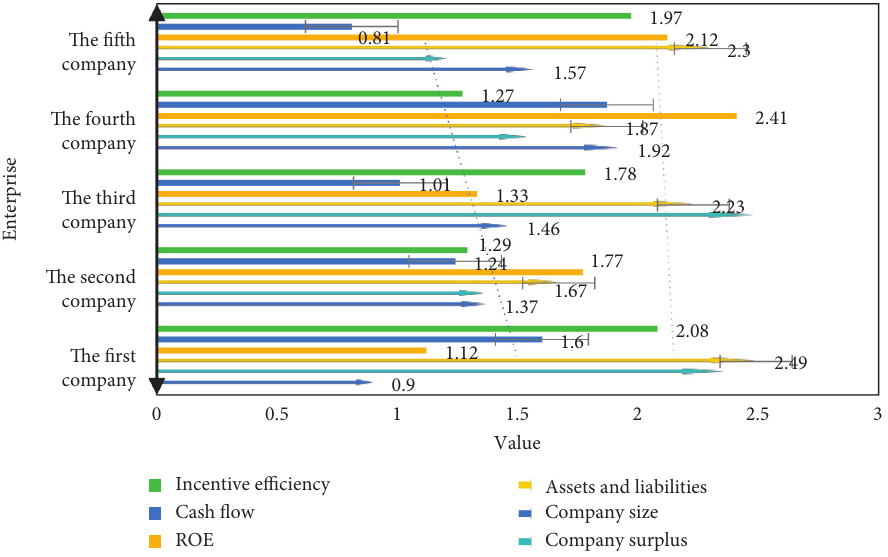
Figure 4: Listed company governance efficiency.